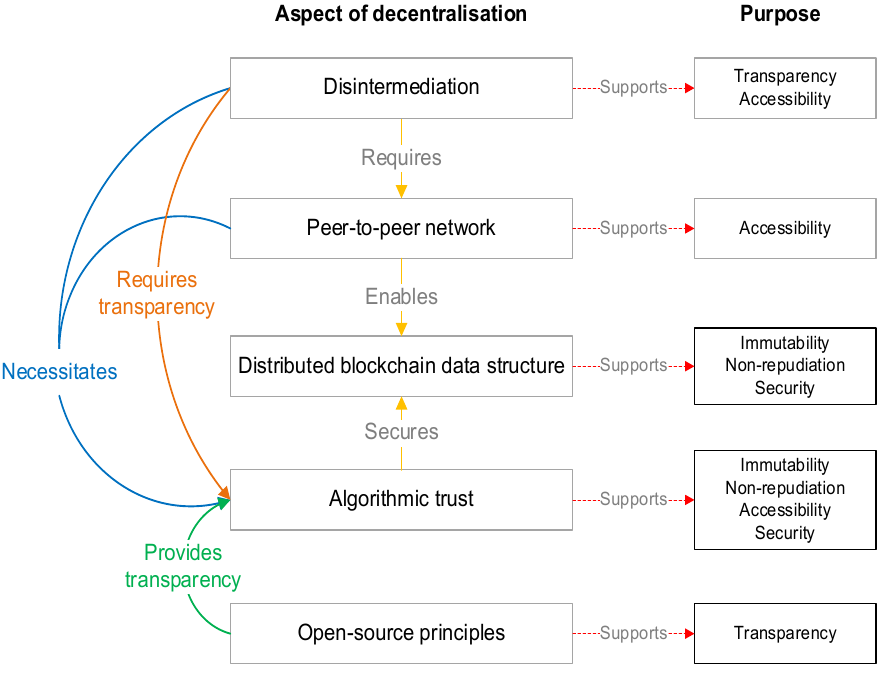
Figure 2: Interrelationships between the aspects of decentralisation and how they support the purpose of a decentralised blockchain